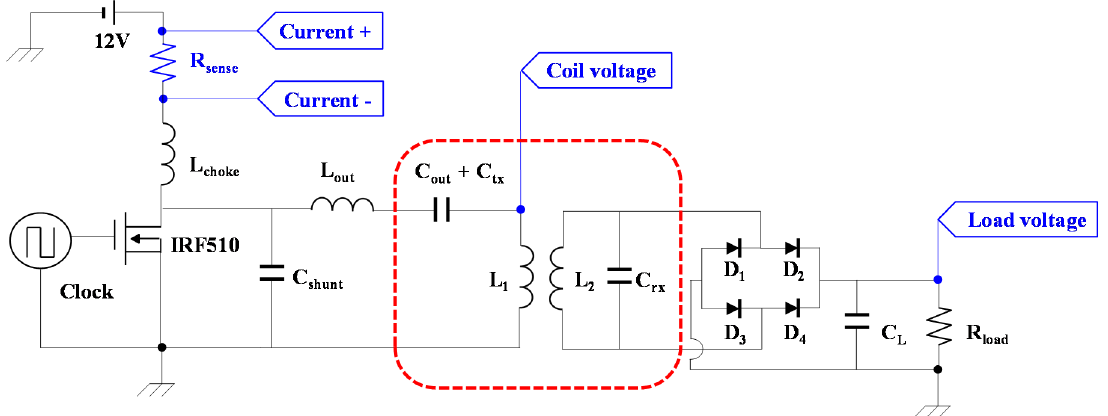
Figure 2. Schematic of fabricated wireless power transfer